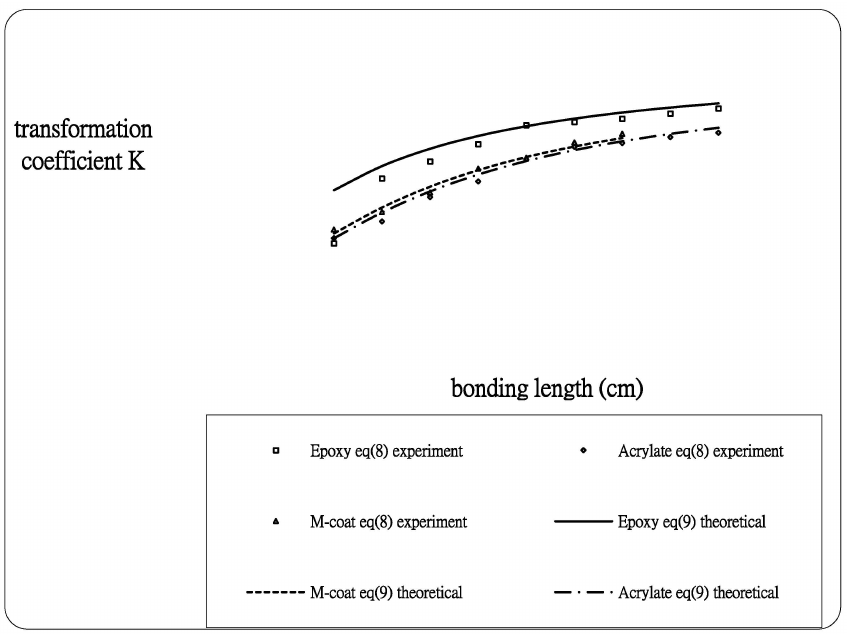
Figure 7. Coefficient of strain transfer versus bonding length for three different adhesives obtained by experimental measurement Equation (8) and theoretical prediction Equation